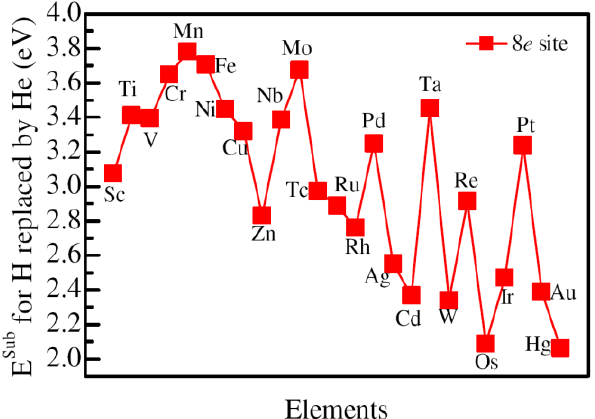
Figure 3. The substitution energy of He replacing H at the 8 e site with the closest Co atom is substituted by various alloying elements.